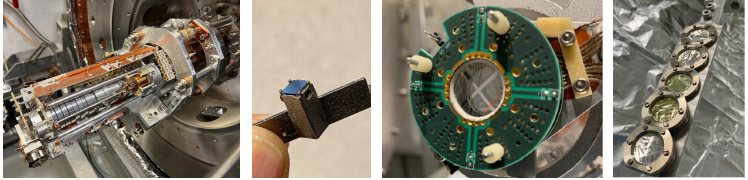
Figure 2: Photographs of upgraded hardware components in AEgIS. Left: H production trap. Central left: positronium target on holder structure. Central right: main degrader with segmented Al coating. Right: Foil ladder for degradation fine